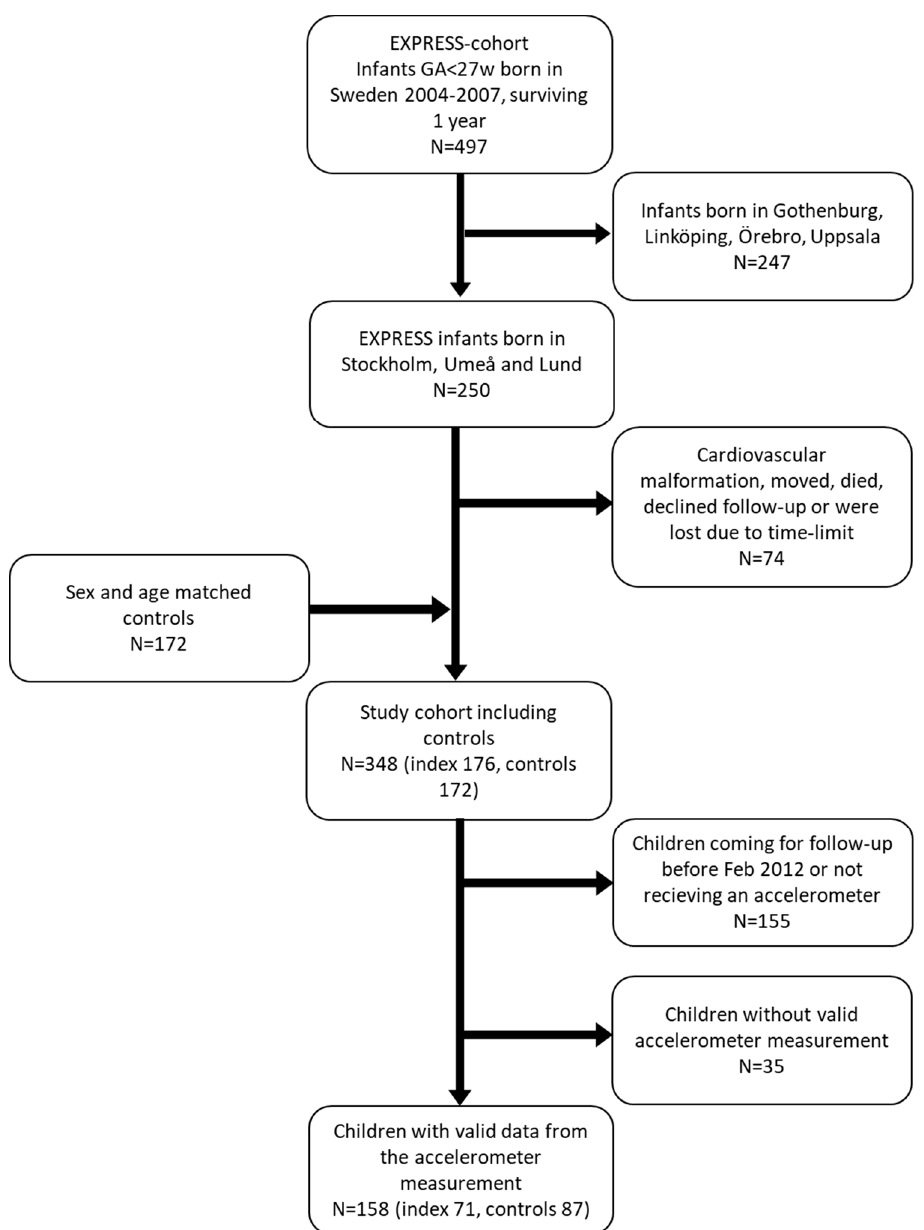
Figure 1. Inclusion of study subjects. The study subjects were recruited from the EXPRESS cohort. Matched controls were identified in the Medical Birth Register. The national follow-up study started in August 2010 and recruitment of participants to this study started in February 2012, After exclusion of subjects lost to time limit and drop-outs not producing valid data, results from 158 children were analyzed.